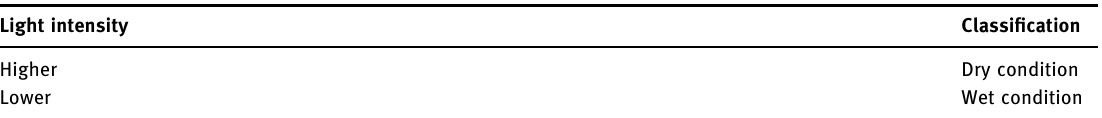
Table 4: Soil moisture classi fi